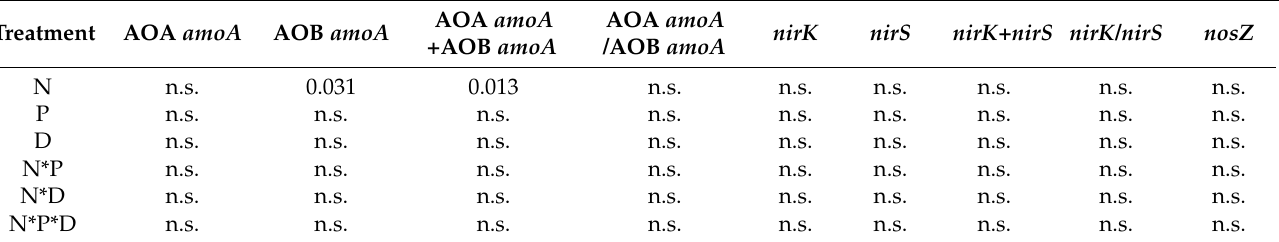
Table 1. Results of three-way ANOVA of gene abundance.